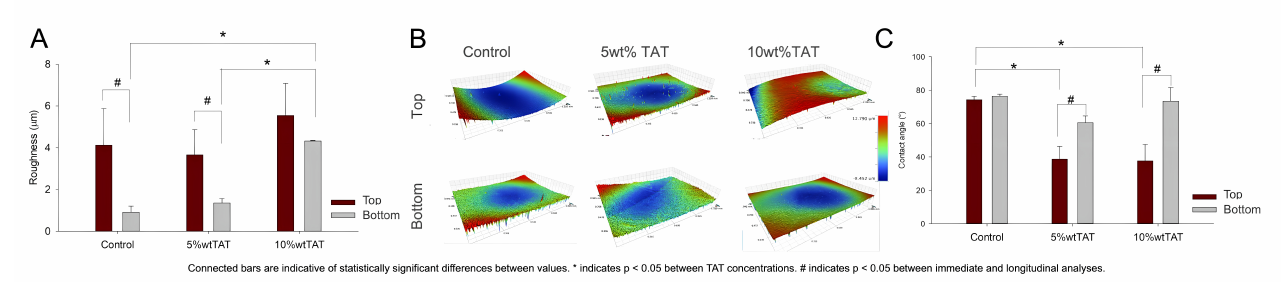
Figure 3. Surface properties on the top and bottom of developed membranes. ( A ) Average values for surface roughness (RA) via profilometry with representative images of the analyzed area showing the distribution of roughness values for higher values (green to red) and lower values (green to blue) in a range of − 8.5 µ m to 12.8 µ m ( B ). Water contact angle in the developed materials ( C ). Bars are a description of average values, while error bars represent standard deviations. Connected bars are indicative of statistically significant differences between values. * Indicates statistically significant differences between TAT concentrations and # between immediate and longitudinal analyses.